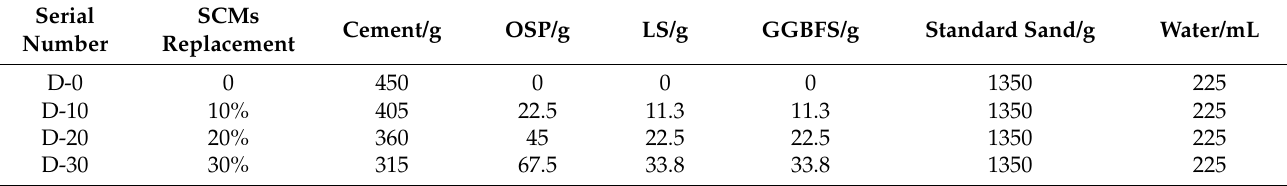
Table 4. Cement mortar ratio of group